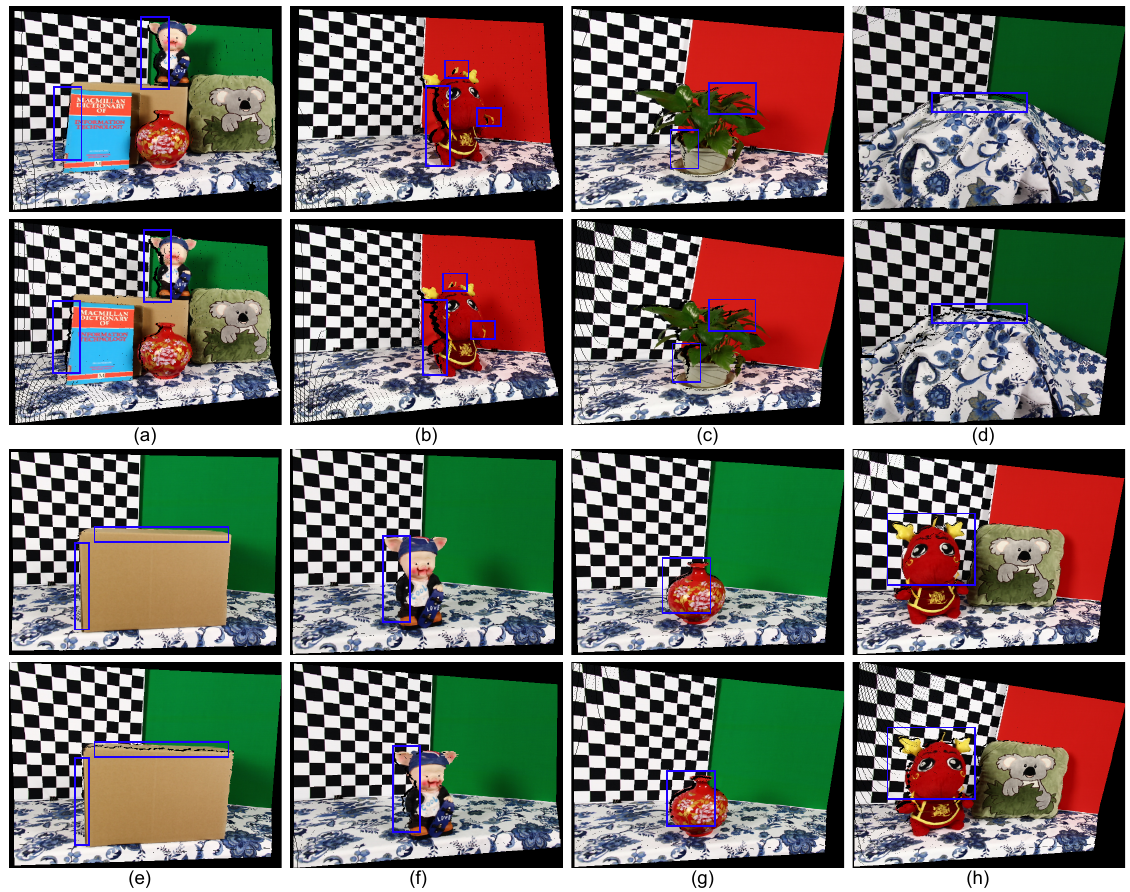
Figure 9. Comparative results for 3D reconstructions. ( a ) Book; ( b ) Dragon; ( c ) Plant; ( d ) Tablecloth; ( e ) Box; ( f ) Piggy; ( g ) Vase; ( h ) Dragon and Kola. Each scene from top to bottom contains the reconstruction using our method and the result using the up-sampled disparity map captured by the Xtion depth